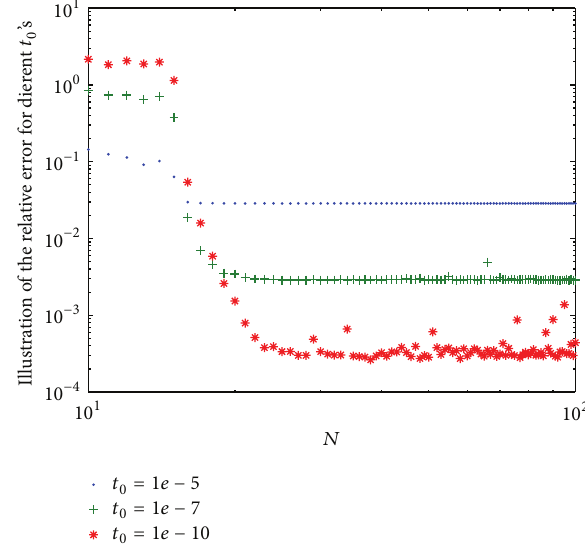
Figure 2: The effect of an increasing number of 𝑁 on the relative error for the cases when 𝑡 0 ∈ {1𝑒 − 5, 1𝑒 − 7, 1𝑒 − 10} with noise-free data.